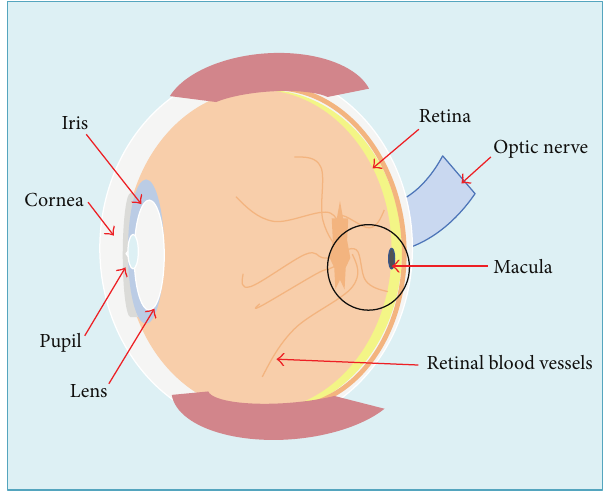
Figure 1: Diagram showing the anatomy of the eye including the location of the macula which is part of the retina at the back of the eye and the key site for